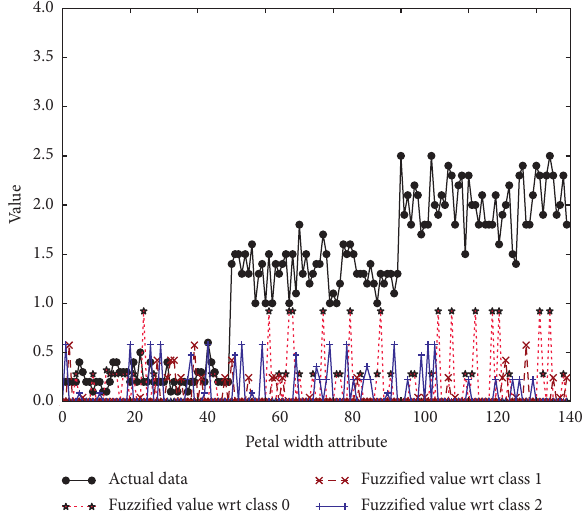
Figure 4: Fuzzification process of IRIS dataset of feature (petal